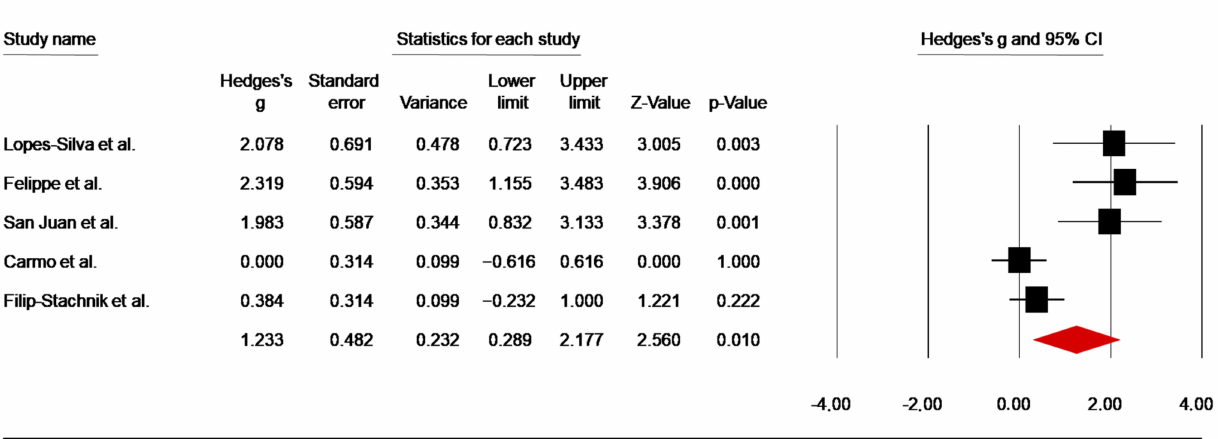
Figure 7. Forest plot of the effect of caffeine intake on [La] post-anaerobic exercise